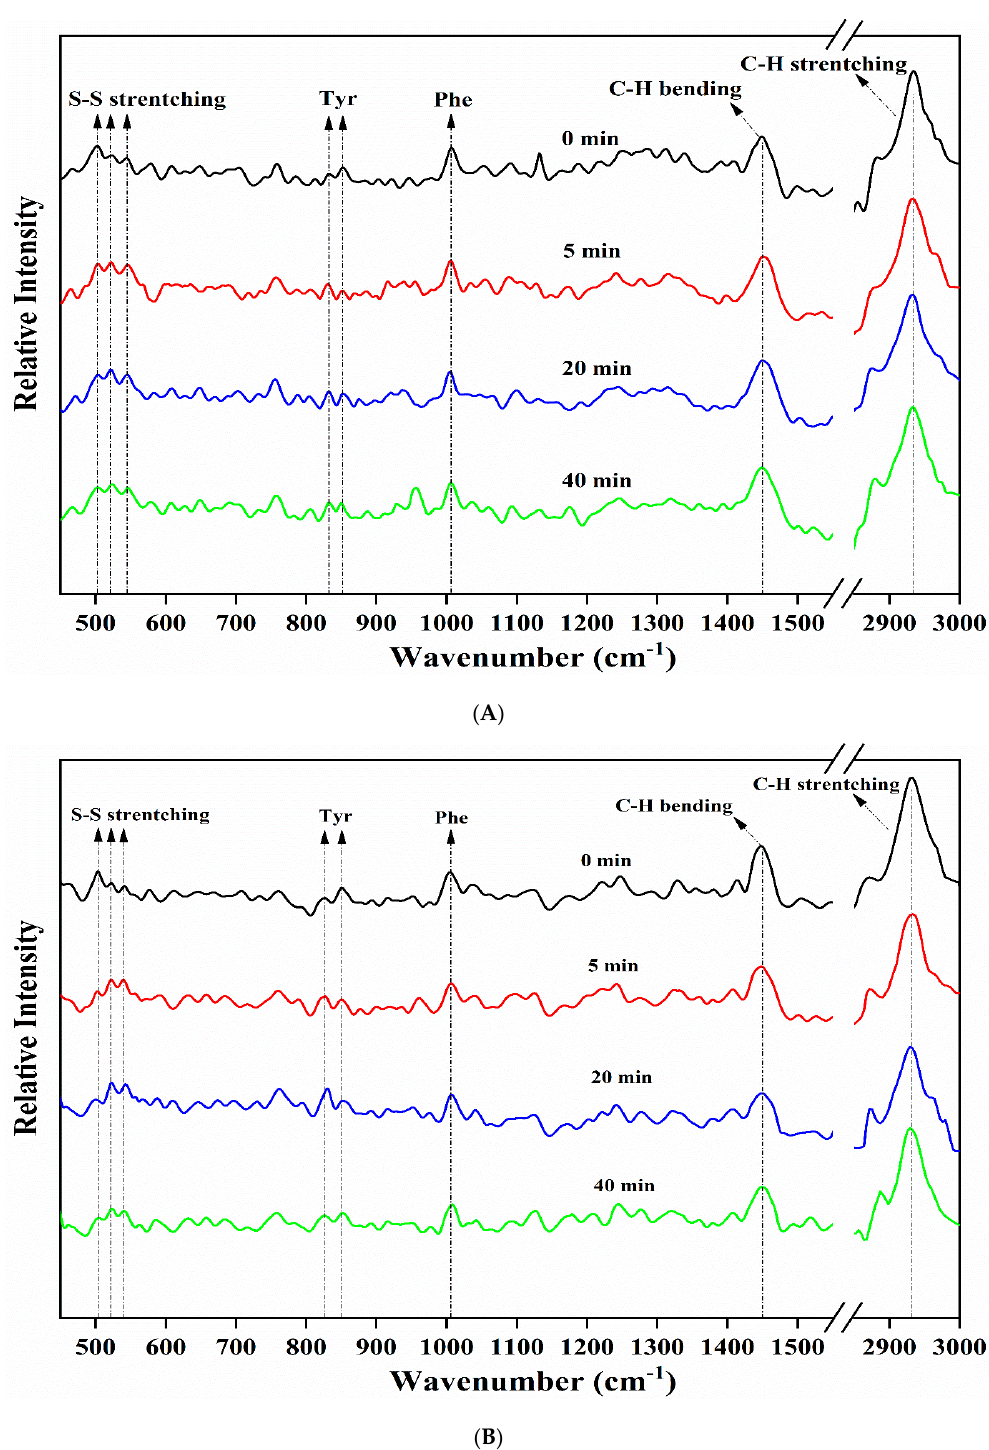
Figure 6. Effect of high-intensity ultrasound treatment (20 kHz at 400 W for 0, 5, 20, 40 min) on the FT-Raman spectra of CSPI ( A ) and DGH ( B ).